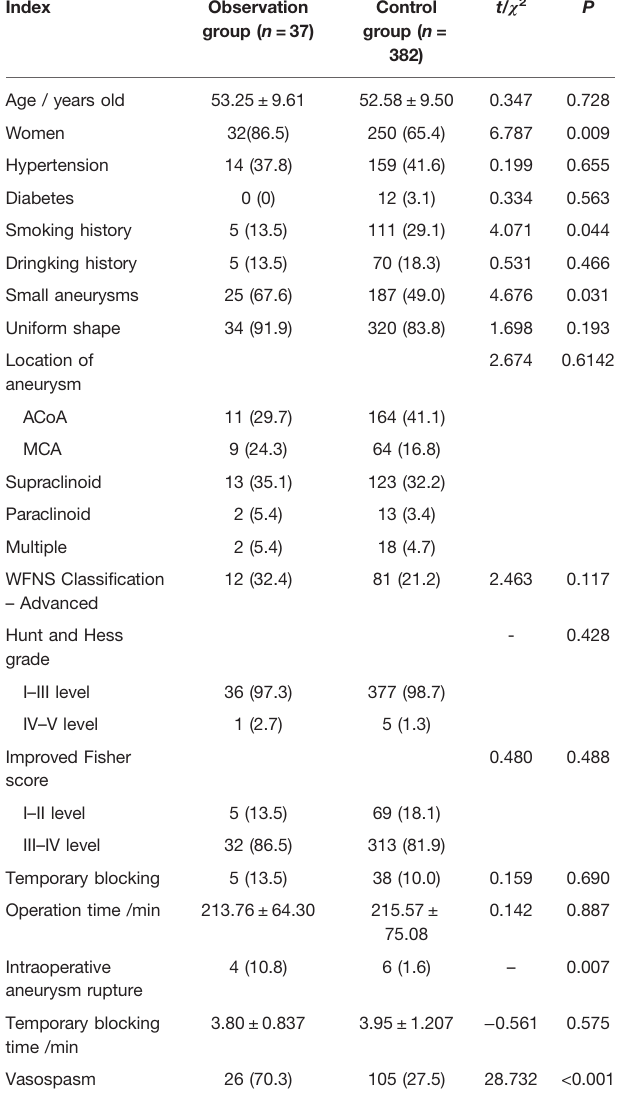
TABLE 1 | Patient information and univariate analysis of DCI for intracranial aneurysm